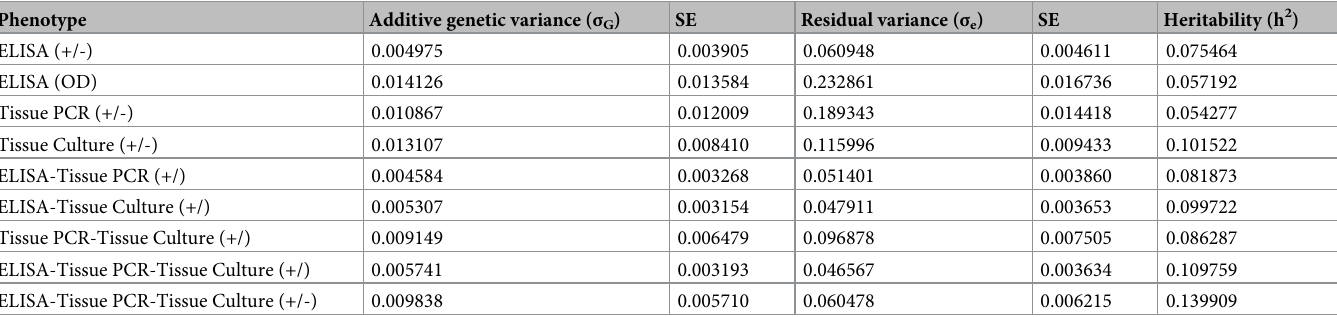
Table 2. Variance components, standard errors (SE), and h 2 estimates for the diagnostic tests and their combinations.